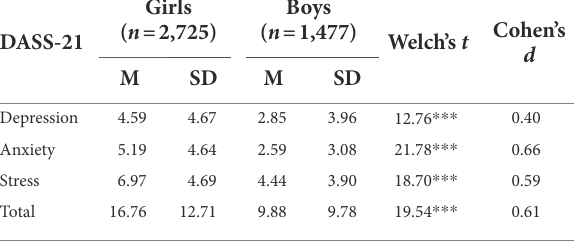
TABLE 4 Standardized factor loadings for the bifactor model of the DASS-21.